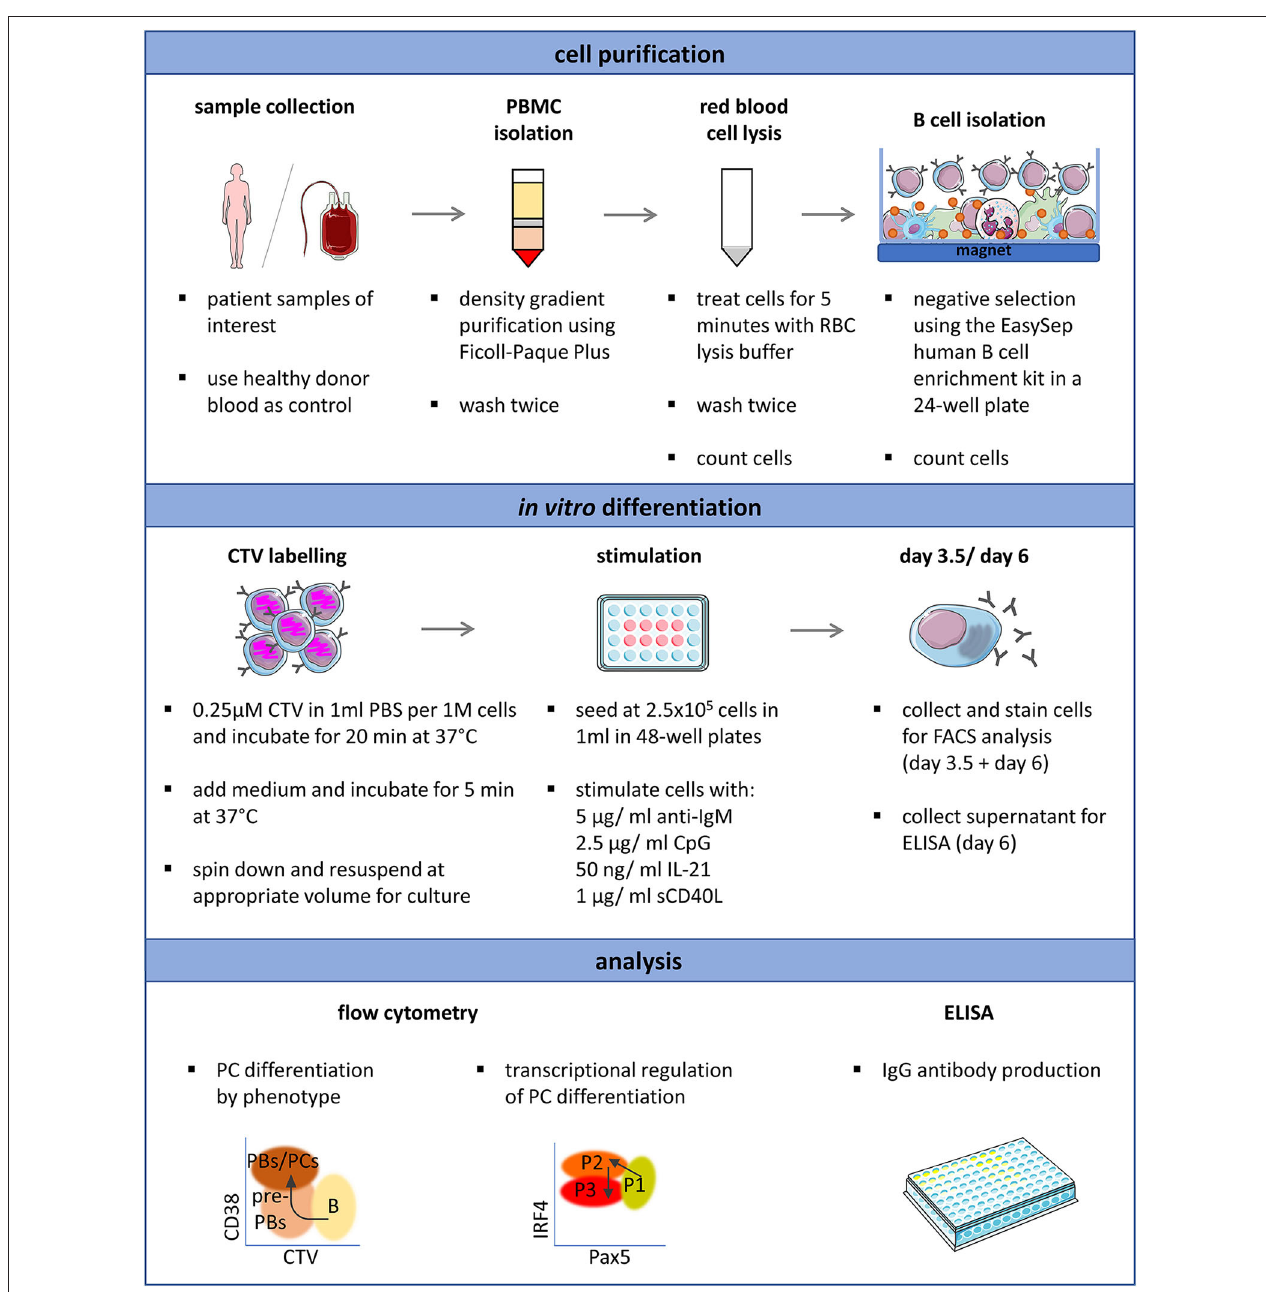
FIGURE 5 | Schematic representation of the optimized protocol for the in vitro induction and analysis of plasma cell differentiation from human primary B cells. Proliferation (CTV), CD38, CD20, Pax5, IRF4, Blimp-1, and Ki67 expression can be analyzed simultaneously and requires 2.5 × 10 5 isolated B cells per time point. This overview was created using images from Servier Medical Art, which are licensed under a Creative Commons Attribution 3.0 Unported License (http://smart. servier.com).